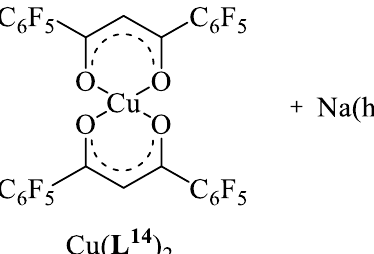
Figure 10. Molecular structure of 21 [70]. Hydrogen atoms have been omitted, CF 3 groups of hfac